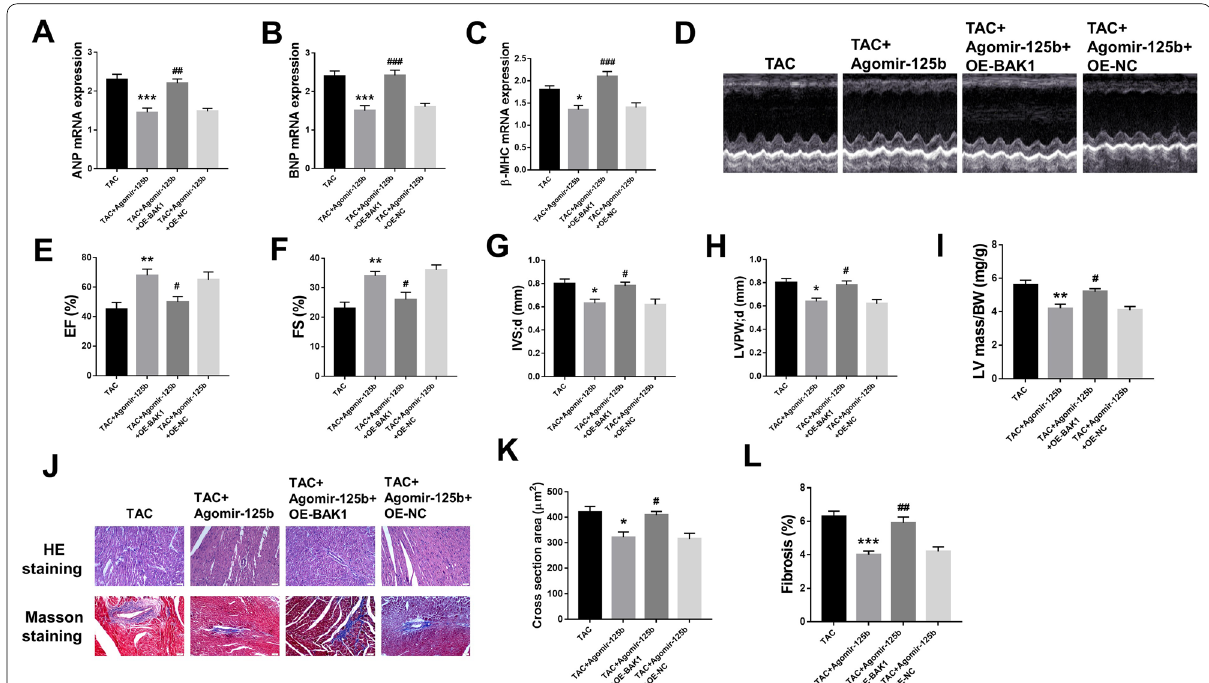
Fig. 5 BAK1 overexpression significantly reversed agomir-125b-induced protective effect in heart failure. TAC mice were transfected with agomor-125b, or co-transfected with agomir-125b and OE-BAK1, or agomir-125b and OE-NC. (A-C) The mRNA level of ANP ( A ), BNP ( B ) and β-MHC ( C ) was evaluated by qRT-PCR (n 5). D Representative images of echocardiographic measurements of mice hearts (n 8). E Left ventricular = = ejection fraction (EF%) (n 8). F Left ventricular fractional shortening (FS%) (n 8). G Left ventricular septal thickness; diastole (IVS; d) (n 8). H Left = = = ventricular posterior wall thickness; diastole, (LVPW; d) (n 8). I Left ventricular mass/body weight (LV mass/BW) (n 8). J Representative images = = of H&E staining and Masson staining of mouse heart tissues (n 8). K The statistical result of H&E staining (n 5). L The statistical result of Masson = = staining (n 5). * p < 0.05, ** p < 0.01, *** p < 0.001 vs. TAC group; ## p < 0.01, ### p < 0.001 vs. TAC agomir-125b = +